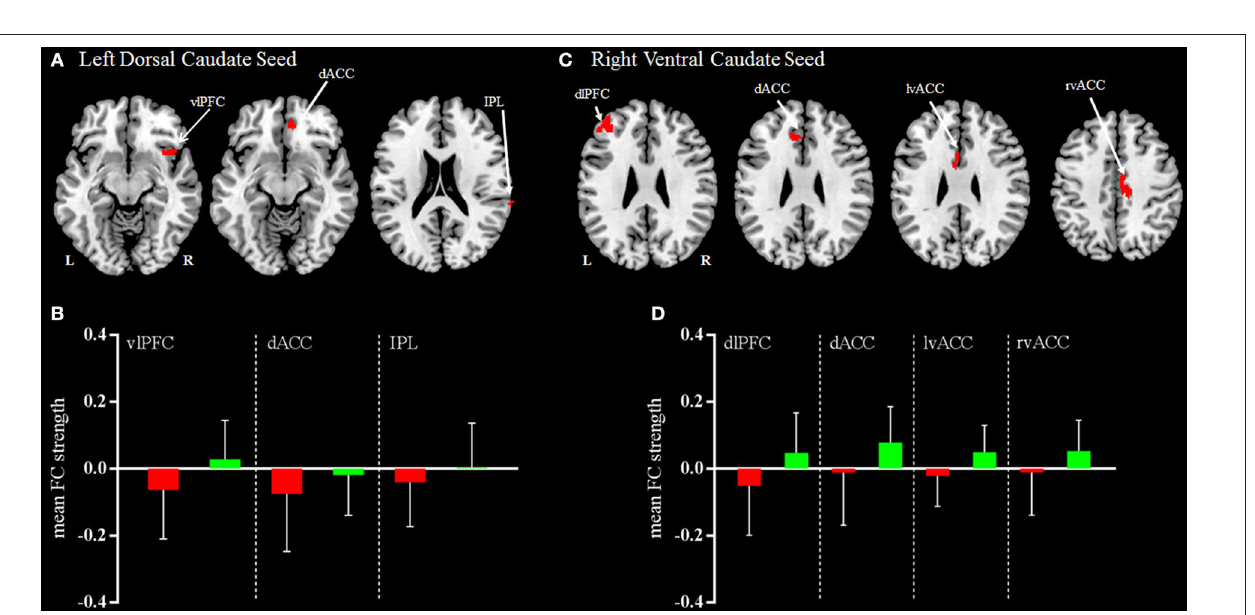
Frontiers in Neurology |